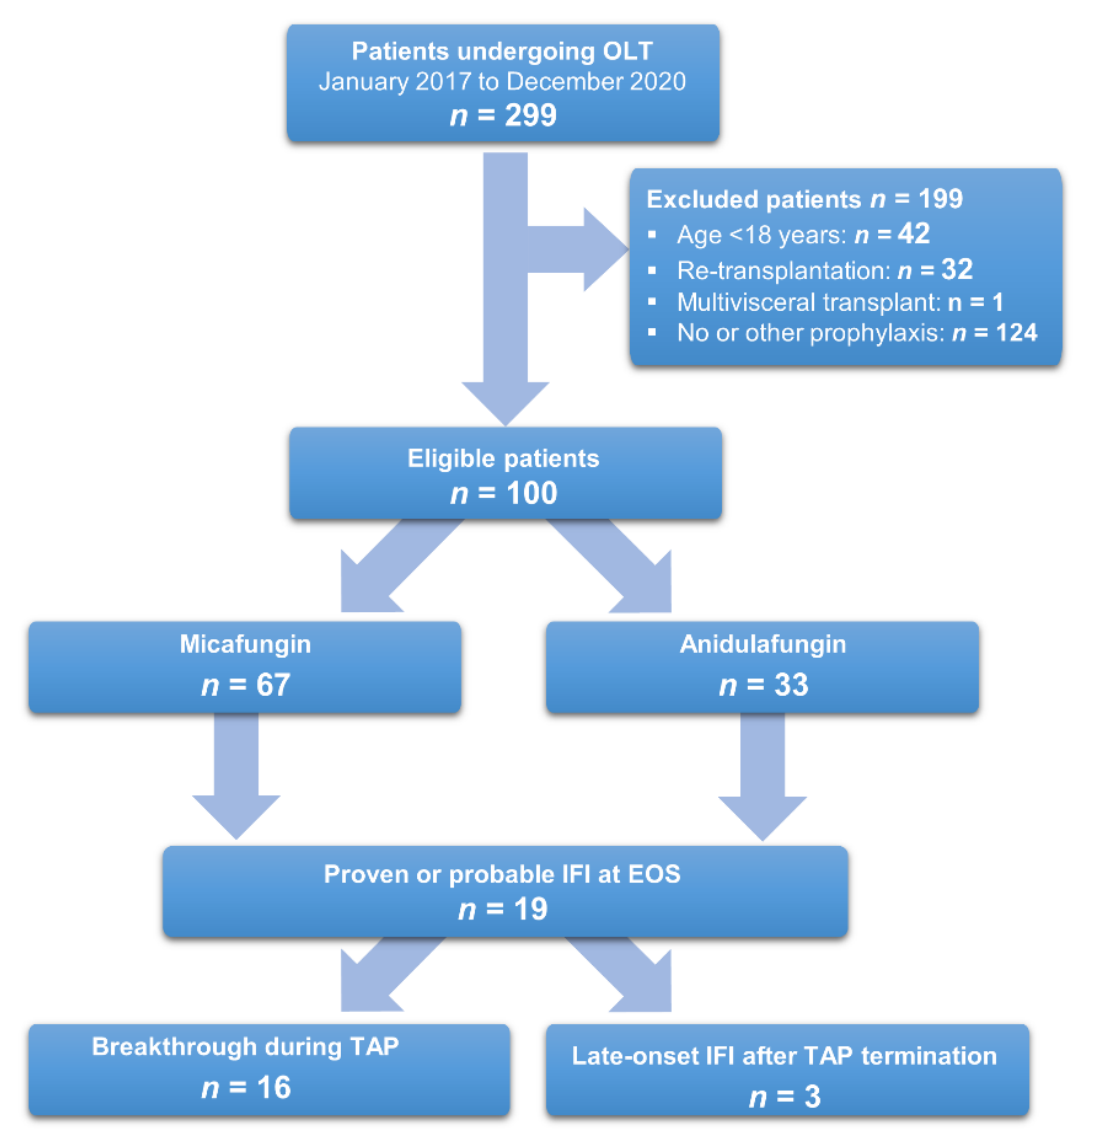
Figure 2. Flow chart of patient selection. Abbreviations: OLT: orthotopic liver transplantation; IFI: invasive fungal infection, b-IFI: breakthrough invasive fungal infection; EOS: end of study. Table 1. Sociodemographic and clinical characteristics, including the perioperative risk factors for b-IFI ( n =